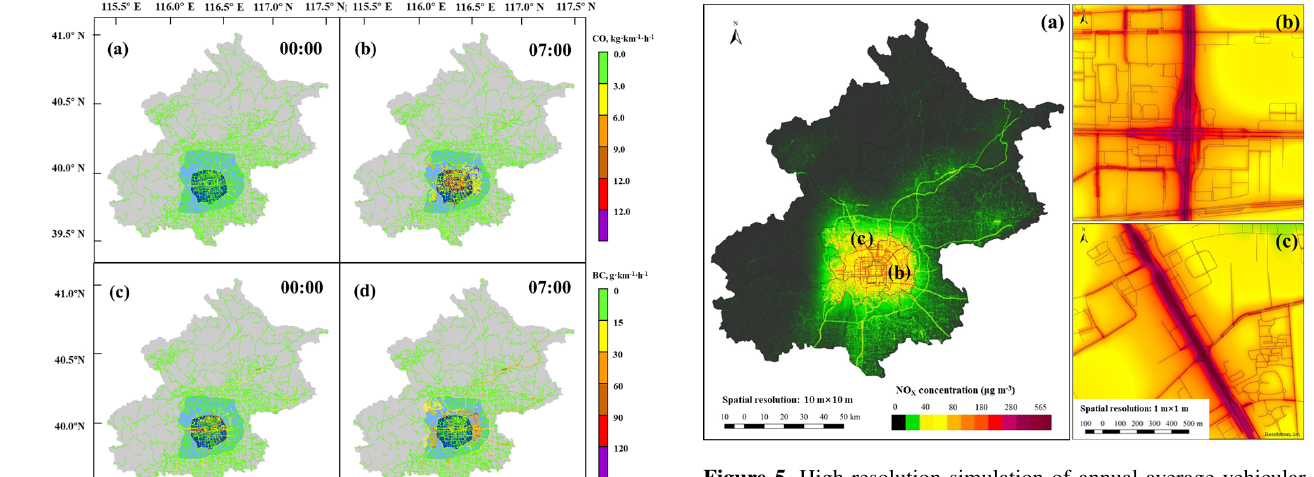
Figure 5. High-resolution simulation of annual-average vehicular NO x concentrations for (a) the entire municipality, (b) Guomao and (c)